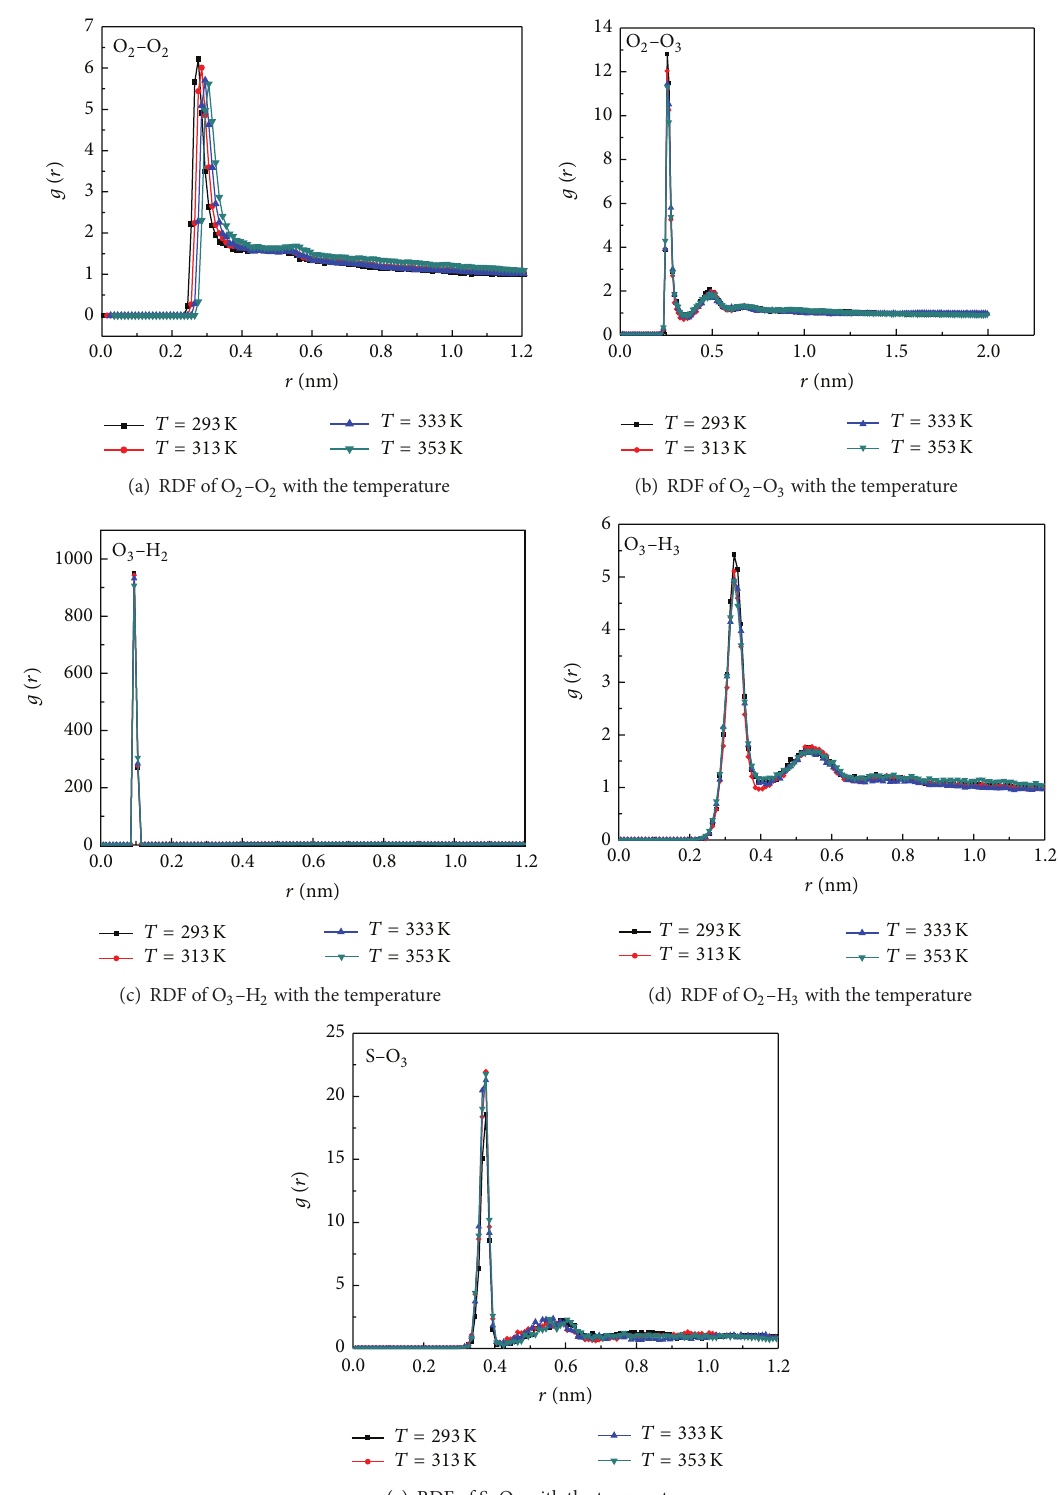
Figure 6: The RDFs of different pairs of particles at different cell temperatures with 𝜆 = 8 and 0 Vm −1